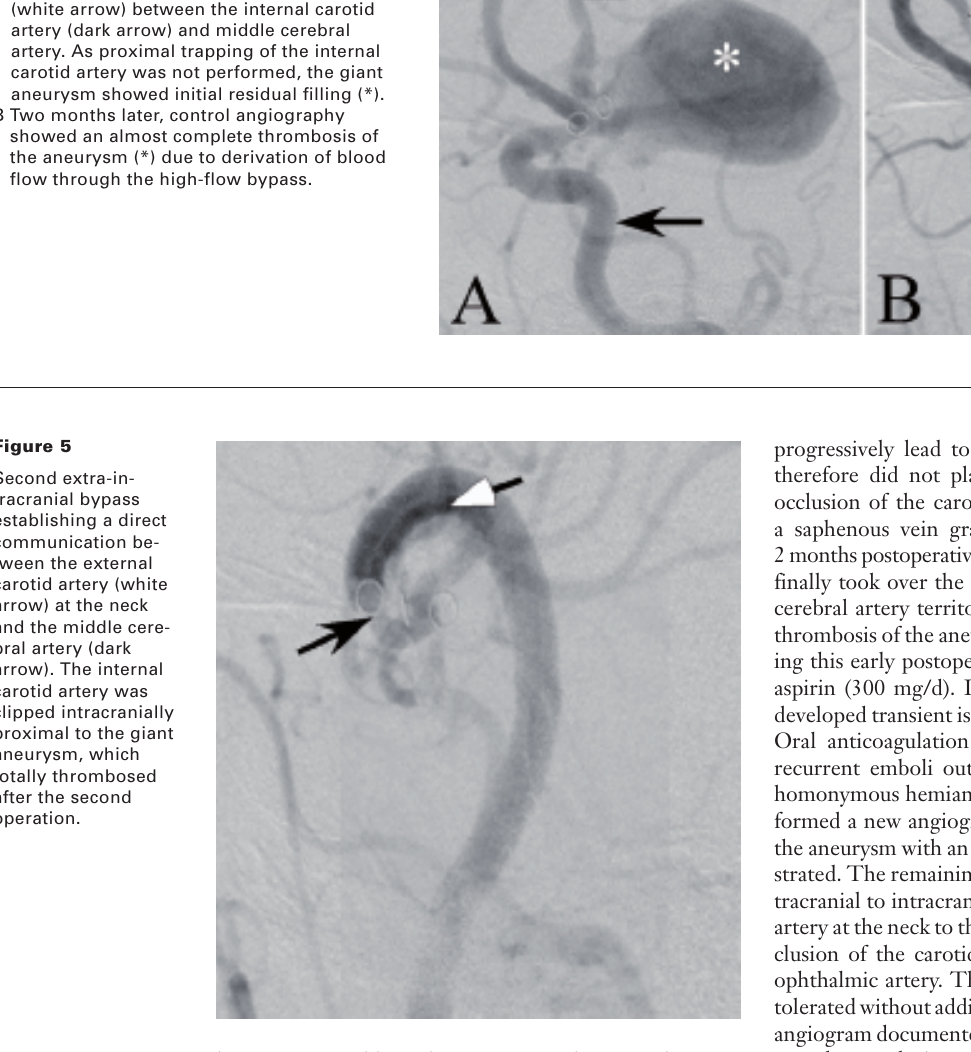
A Lateral view of cerebral angiography show- ing the first intracranial high-flow bypass (white arrow) between the internal carotid artery (dark arrow) and middle cerebral artery. As proximal trapping of the internal carotid artery was not performed, the giant aneurysm showed initial residual filling (*). B Two months later, control angiography showed an almost complete thrombosis of the aneurysm (*) due to derivation of blood flow through the high-flow bypass.